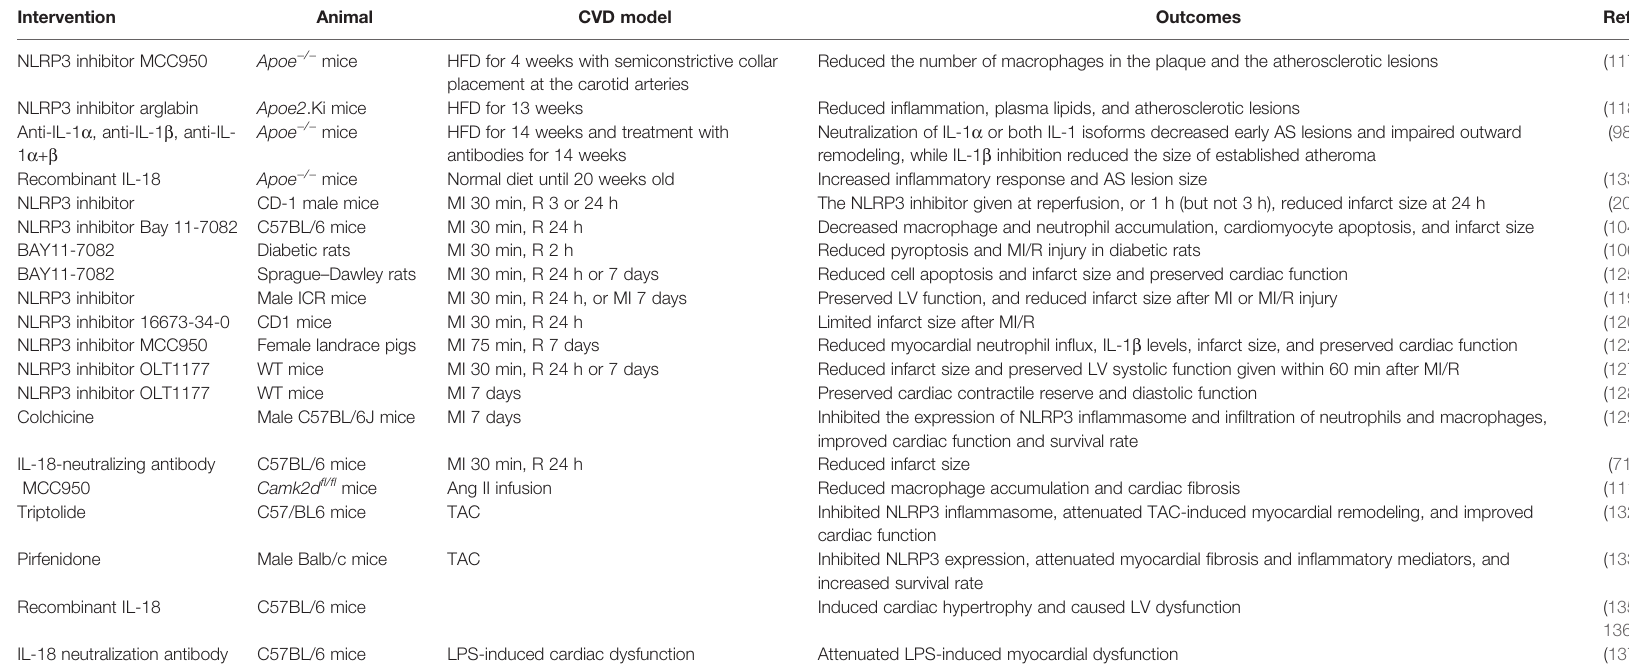
TABLE 2 | Pharmacological interventions of in fl ammasomes in animal models of